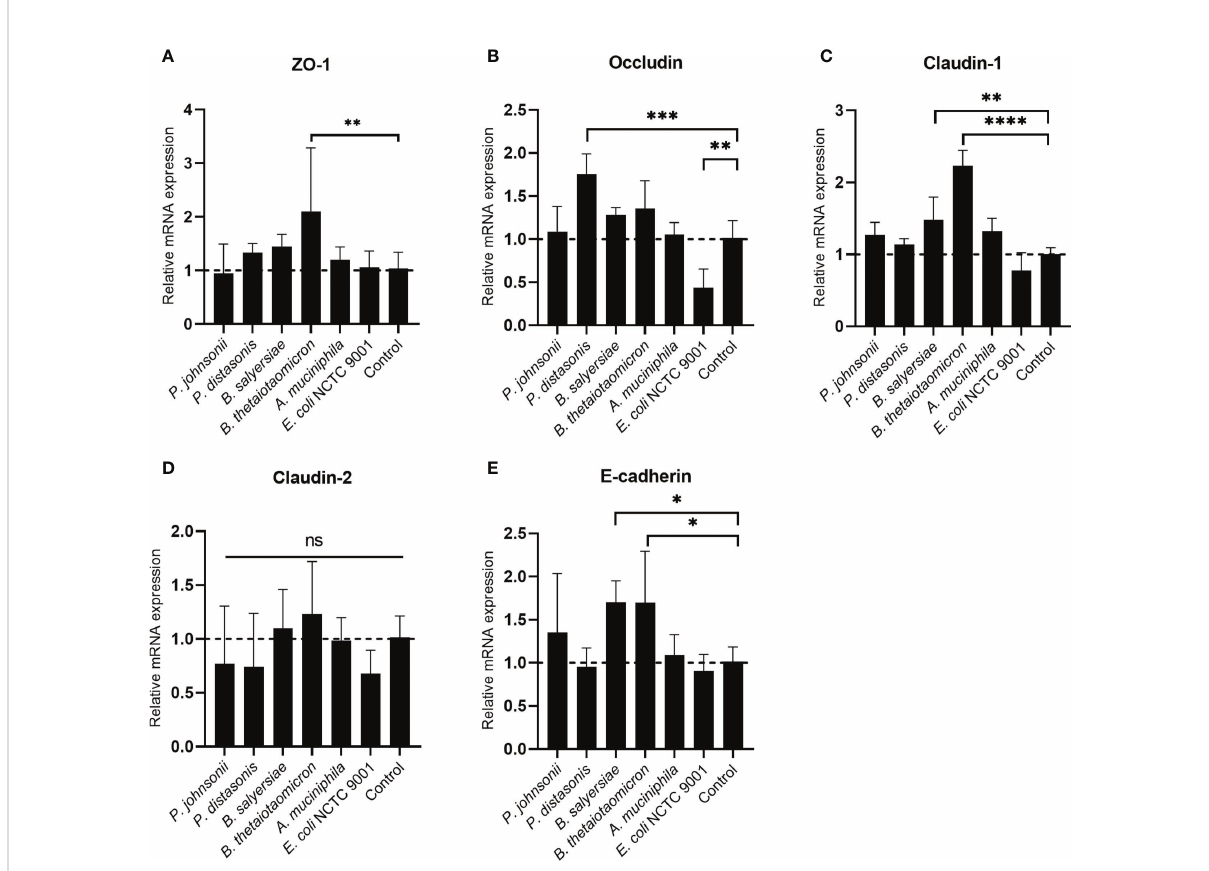
FIGURE 5 Impact of selected mucin-degrading gut commensals on the mRNA expression of TJ protein genes. Developed Caco-2 cell monolayers were co-cultured with gut commensals 24 h. The mRNA level of TJ protein Zo-1 (A) , Occludin (B) Claudin-1 (C) , E-cadherin (D) and Claduin-2 (E) were detected by qRT-PCR. Error bars represent the standard deviation of the mean values from at least three replicates. * p < 0.05, ** p < 0.01, *** p < 0.001, **** p < 0.0001 treated groups vs. control group, ns: no signi fi cant. Signi fi cance was determined by one-way ANOVA followed by Dunnett ’ s test for multiple comparisons.